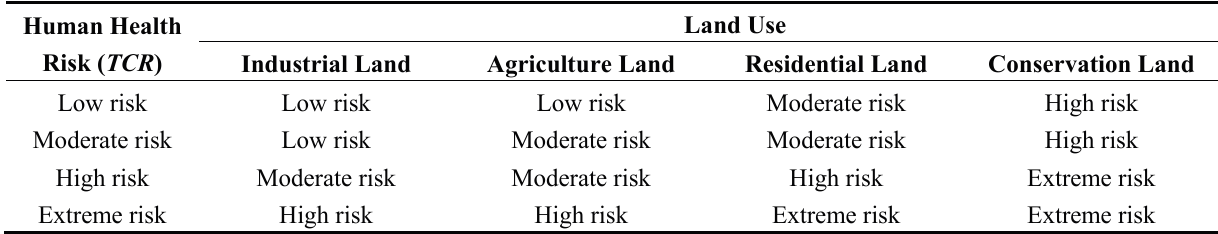
Table 2. Classification method of soil integrated